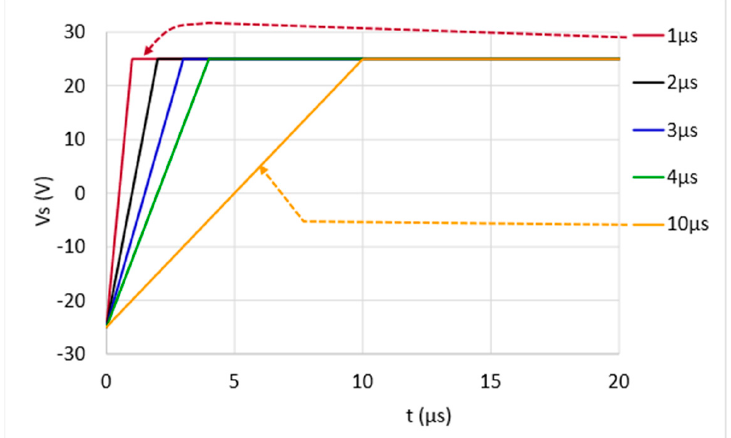
Figure 8. Ramp voltage signals with different initial slopes, while increasing from -25 V to +25 V. Magnitudes of the voltages after the slip time were constant at +25 V until 20 µs.